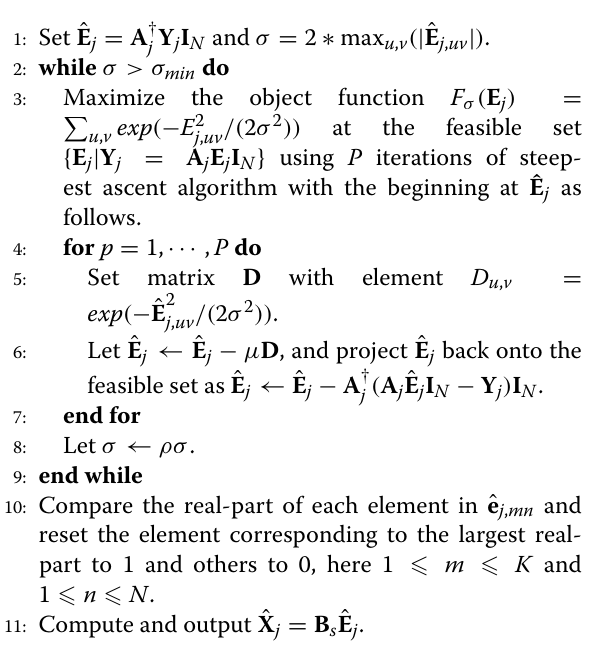
Algorithm 2 2D-SL0-SD signal detection method [38]